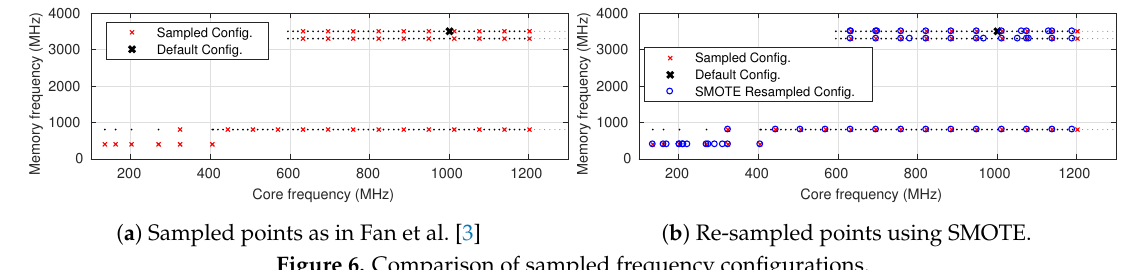
Figure 6. Comparison of sampled frequency